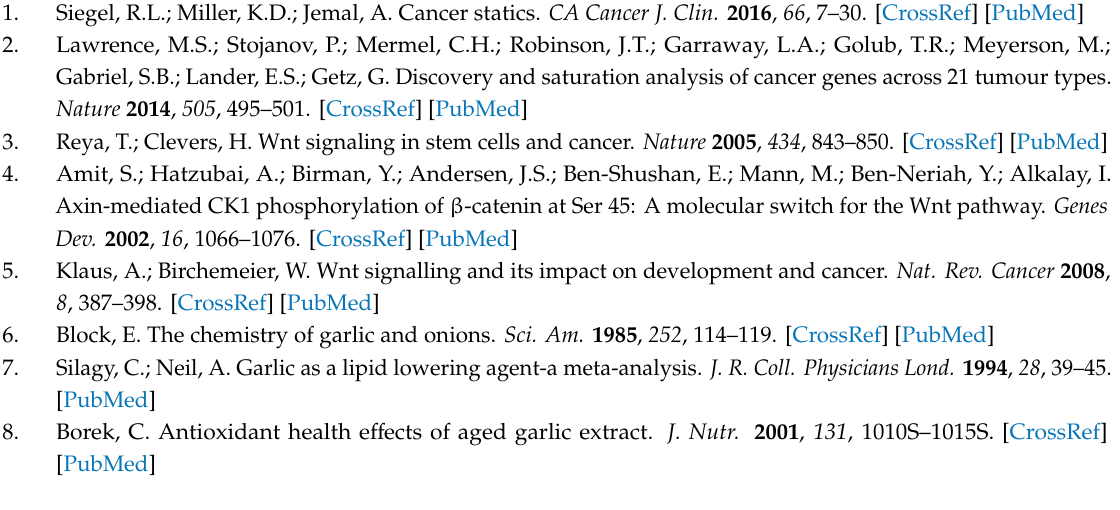
Figure S1: E ff ects of Z-ajoene on Wnt / β -catenin pathway in Wnt3a-activated HEK293 reporter